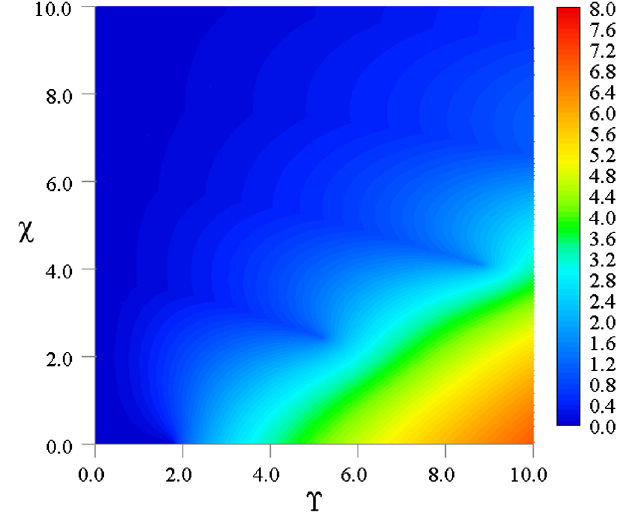
FIG. 13. The growth factor g × T (of the most unstable mode) FIG. 15. The flat contour plot of the growth factor g × T s as a function of ϒ for various TFCTs (TFCT ¼ 1 by the red line, the most unstable mode) as a function of ϒ and χ at the rms bunch TFCT ¼ 1 . 8 by the green lien, TFCT ¼ 2 by the black line, and length of 2 cm in the trapezoidal wake model for the Vlasov TFCT ¼ 2 . 2 by the blue line, respectively) at zero chromaticity. analysis with the Gaussian bunch